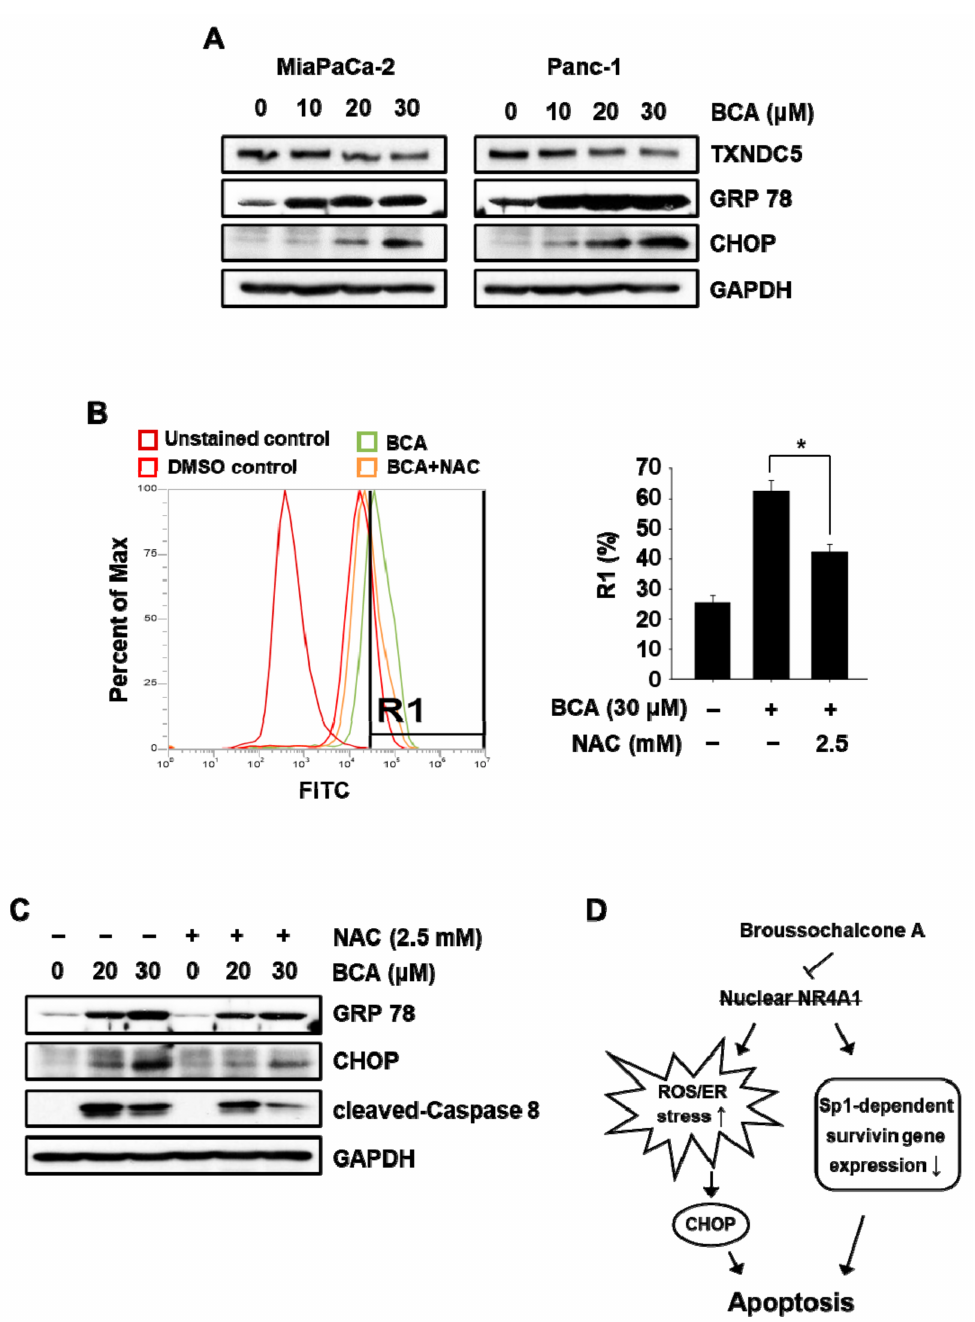
Figure 5. BCA induces ROS-mediated ER stress in pancreatic cancer cells. ( A ) Cells were treated with BCA for 24 h, and whole-cell lysates were analyzed by Western blot analysis. GAPDH was used as a loading control. ( B ) MiaPaCa-2 cells were treated with BCA for 6 h, and intracellular ROS level was measured by flow cytometry as described in the Section 3. ( C ) MiaPaCa-2 cells were treated with BCA for 24 h in the presence or absence of N-acetylcysteine (NAC), and whole cell lysates were analyzed by Western blot analysis. GAPDH was used as a loading control. ( D ) Schematic diagram illustrating NR4A1-dependent apoptosis by BCA. * p < 0.05 vs.